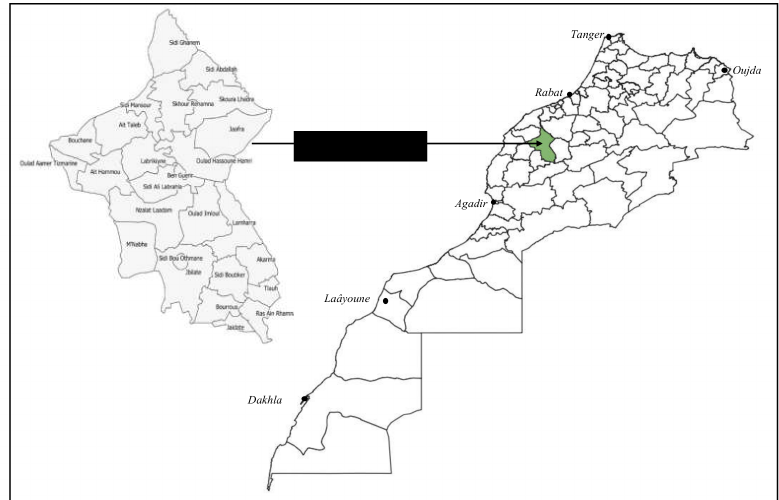
Figure 6. Rehamna province localization (study